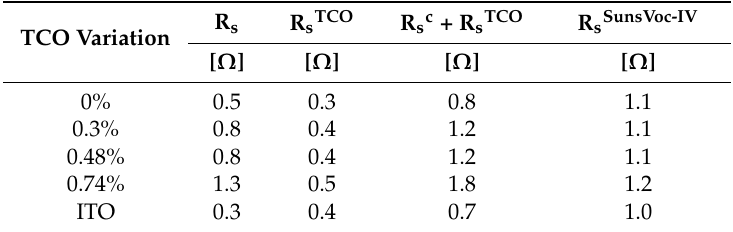
Table 1. Calculated contact resistance (R sc ), transparent conductive oxide (TCO) resistance (R sTCO ) and its addition. Series resistance of the cell extracted from SunsV oc and IV measurements (R sSunsVoc-IV ). R s R sTCO R sc + R sTCO R sSunsVoc-IV TCO Variation [ Ω ] [ Ω ] [ Ω ] [ Ω ]